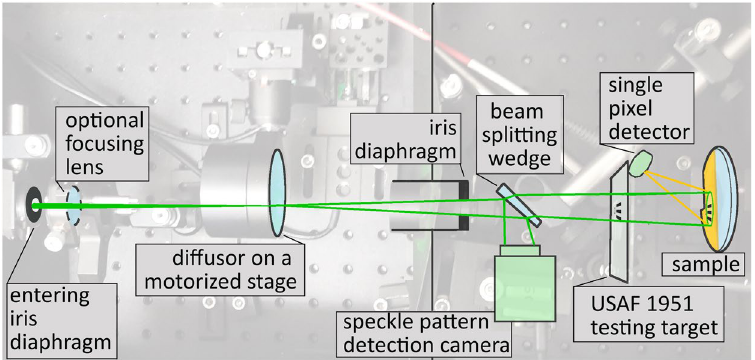
Figure 1. Photograph of the experimental setup overlaid with a simple scheme. The laser focusing lens can be used to modify the speckle pattern properties (see text for details). USAF 1951 testing target was used to verify the resolution of the imaging setup. The single pixel detector in the presented results was a fiber-coupled